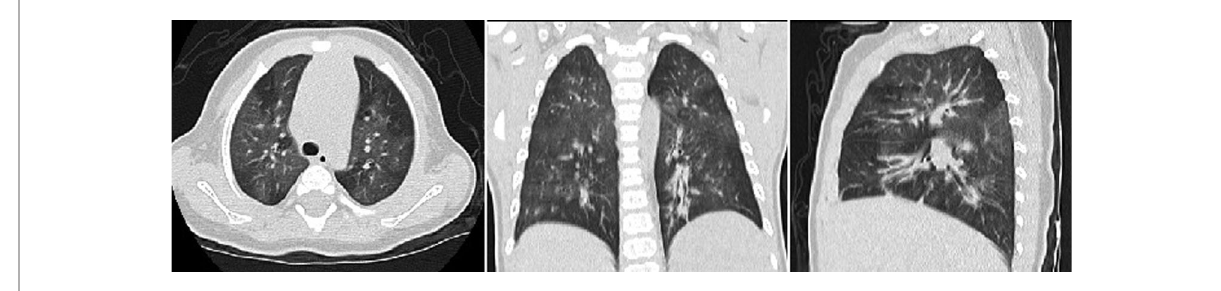
FIGURE 1 The chest computed tomography of the patient 7 showed mosaic perfusion and air trapping for bronchiolitis obliterans at the